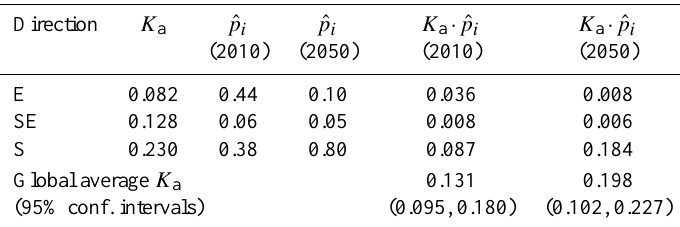
Table 1. Agitation coefficients ( K a ) for the studied directions, and the frequency of storm presentation ( ˆ p i ) under projected present (2010) and future (2050) conditions.